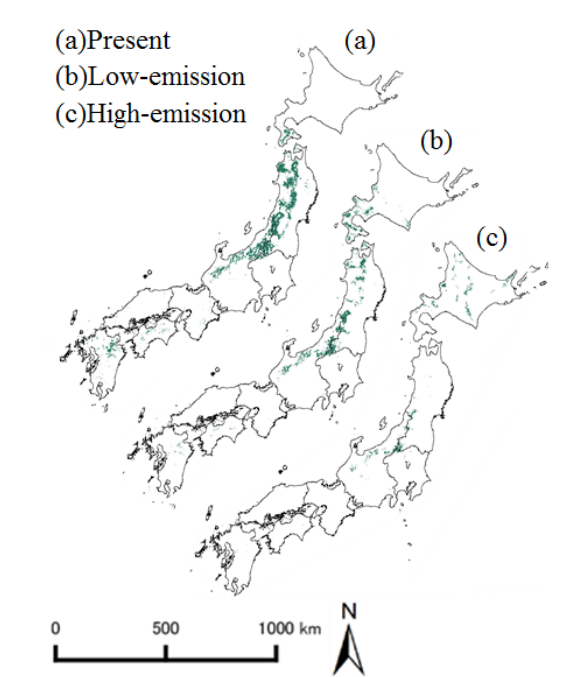
Figure 8. Distribution of growth suitable mesh for beech- dominated deciduous forests under present and future climatic conditions.